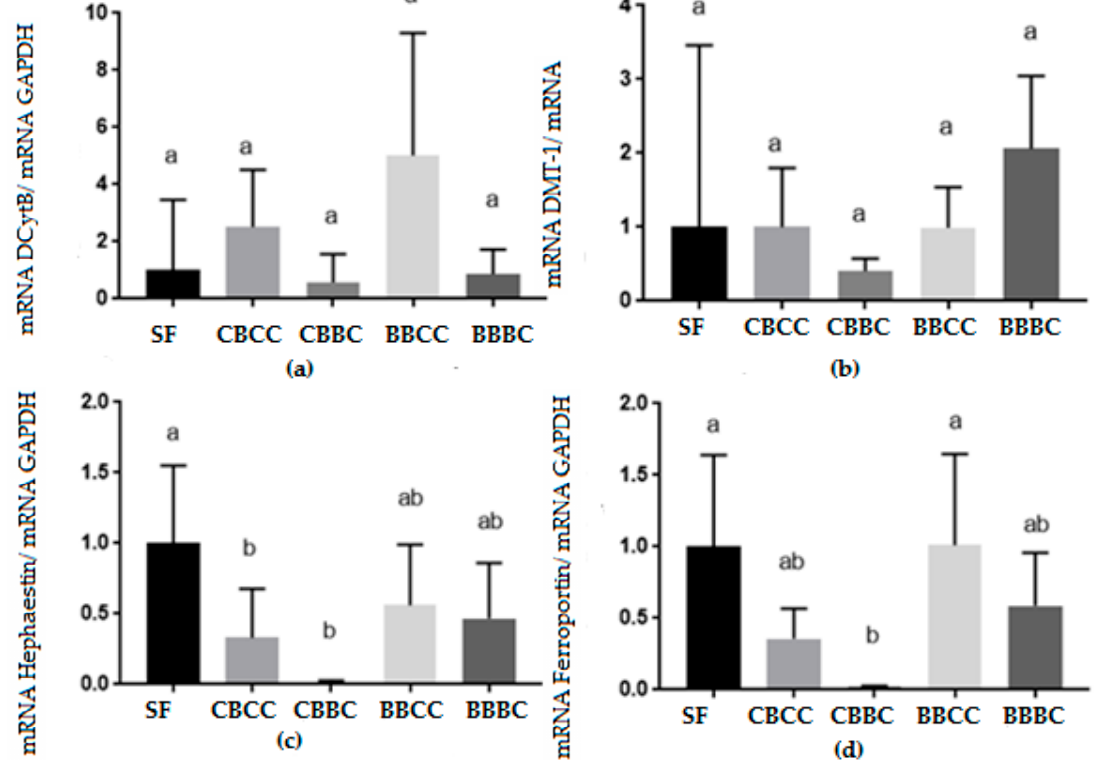
Figure2. ( a )DcytBmRNA;( b )DMT-1mRNA;( c )HephaestinmRNA;( d )FerroportinmRNA.SF:Ferrous Figure 2. ( a ) DcytB mRNA; ( b ) DMT-1 mRNA; ( c ) Hephaestin mRNA; ( d ) Ferroportin mRNA. SF: sulfate; CBCC:Conventional beans + conventional cassava; CBBC: Conventional beans + biofortified Ferrous sulfate; CBCC:Conventional beans+conventional cassava; CBBC: Conventional cassava; BBCC: Biofortified beans + conventional cassava; BBBC: Biofortified beans + biofortified cassava. beans+biofortified cassava; BBCC: Biofortified beans+conventional cassava; BBBC: Biofortified beans Means followed by the same letter in the bars do not di ff er from each other ( p > + biofortified cassava. Means followed by the same letter in the bars do not differ from each other ( p > 0.05).